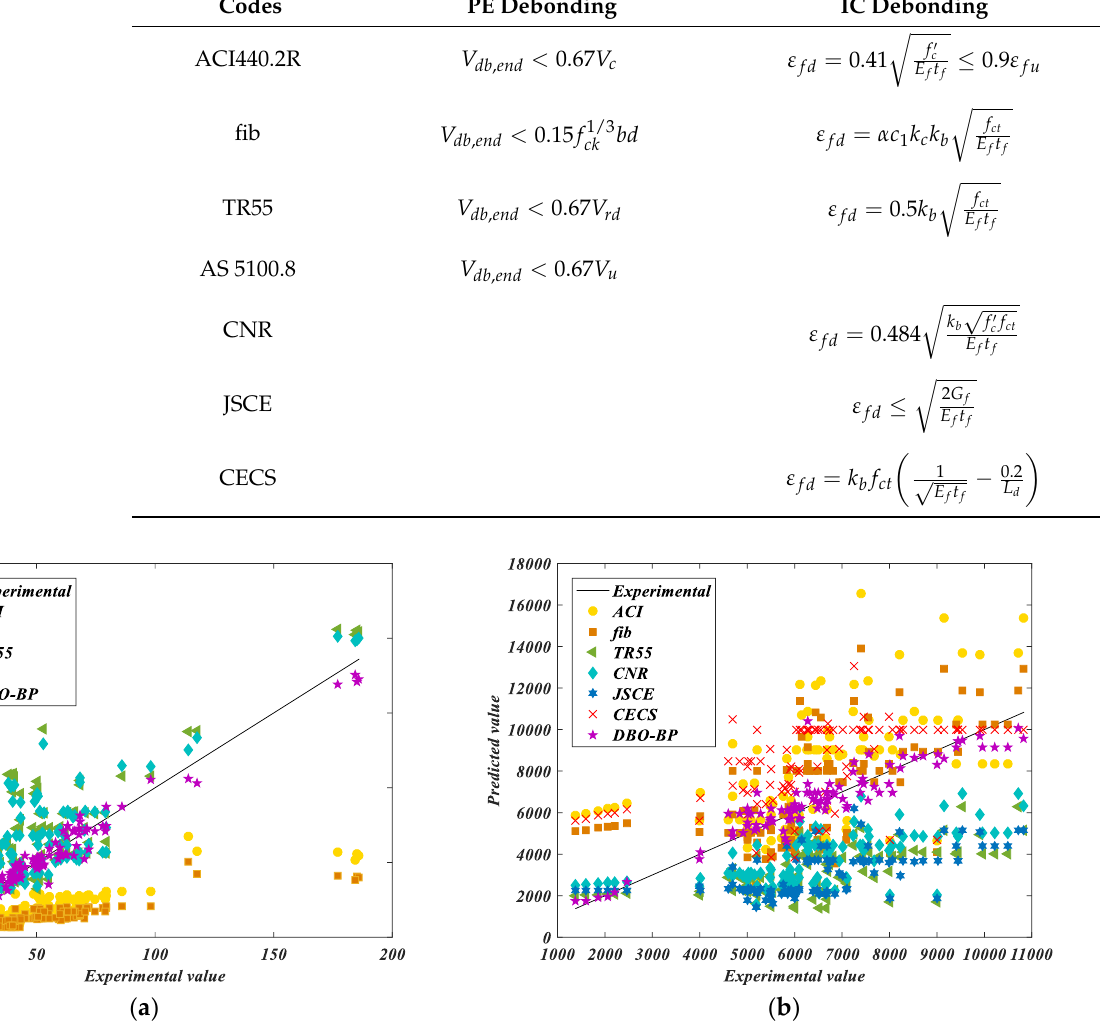
Figure 9. Evaluation of the models. ( a ) PE debonding; ( b ) IC debonding. Table 3. Model